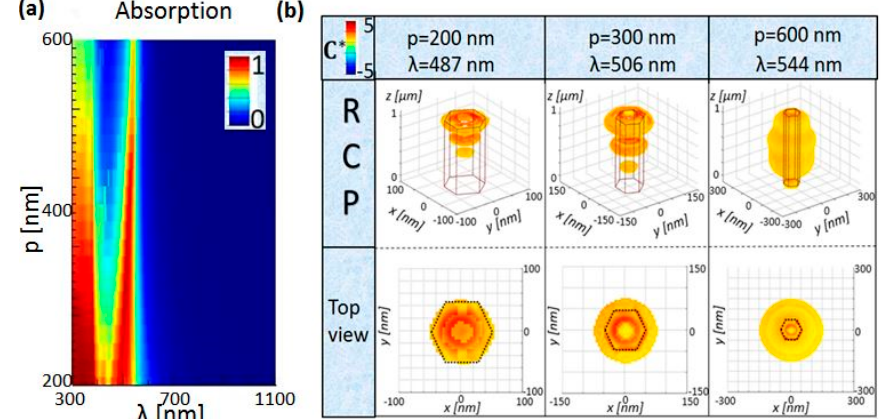
Figure 3. ( a ) Absorption dependence on the NW array periodicity for r = 50 nm and L = 1000 nm. ( b ) Upper part: C* distribution in the unit cell for p = 200 nm, p = 300 nm, and p = 600 nm at the corresponding NW resonant wavelengths for RCP excitation; bottom: xy top-view of the corresponding distribution from the upper part. Black hexagonal line shows the geometric position of the NW xy cross-section. Only RCP excitation is shown as LCP leads to the sign inversion.